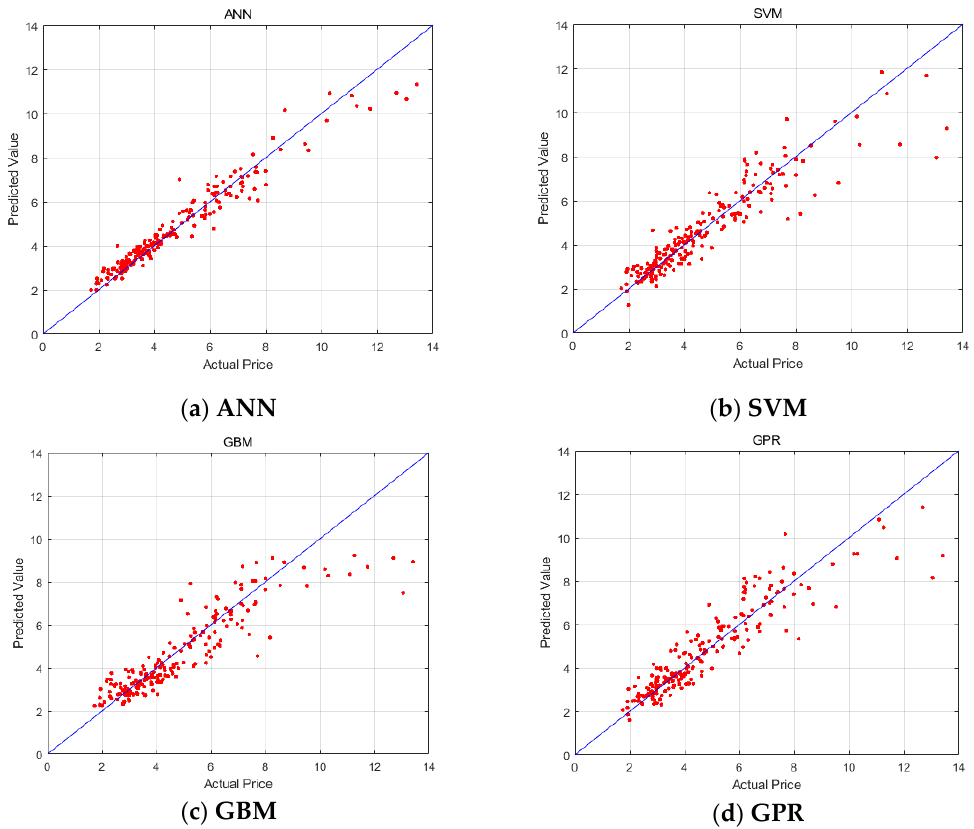
Figure 5. Distribution suitcases between predictive values and actual values.